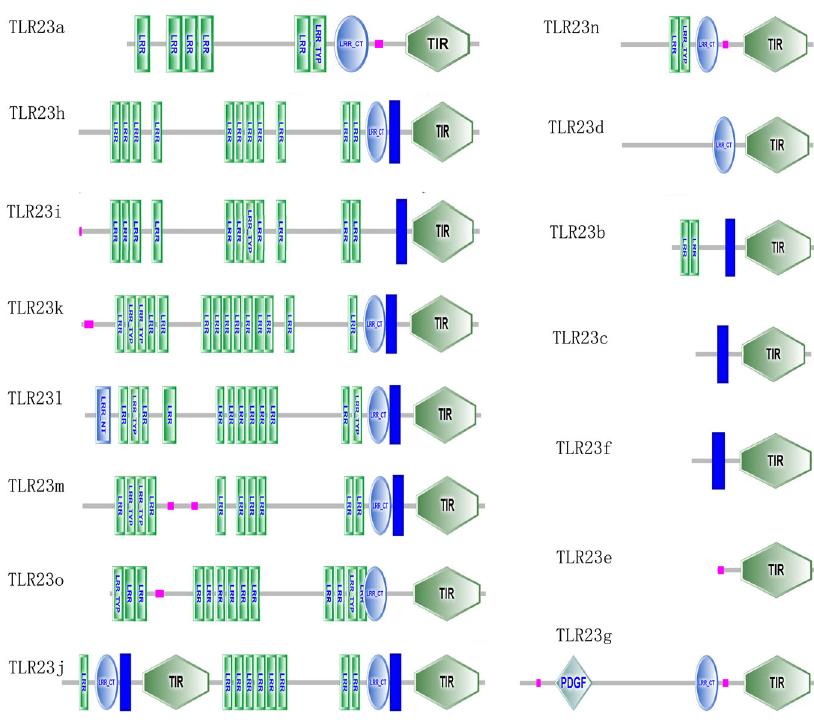
Fig. 5 Protein domain structures of TRL23 in yellowstripe goby. LRR leucine-rich repeat, LRR-TYP leucine-rich repeat typical subfamily, TIR Toll/IL-1